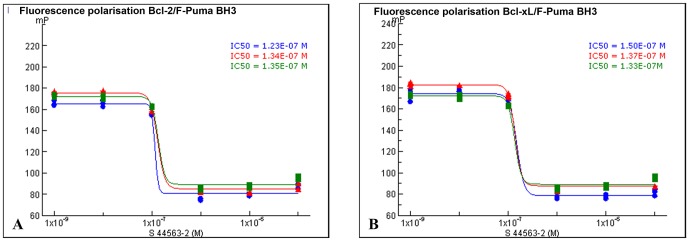
Inhibition of the interaction between Bcl-2 or Bcl-XL and fluorescent Puma BH3 peptide measured by the decrease of fluorescence polarisation as a function of S44563-2 concentration.Three independent experiments are presented. FP data are presented in millipolarization units (mP). For each experiment, measures are assessed in triplicate.